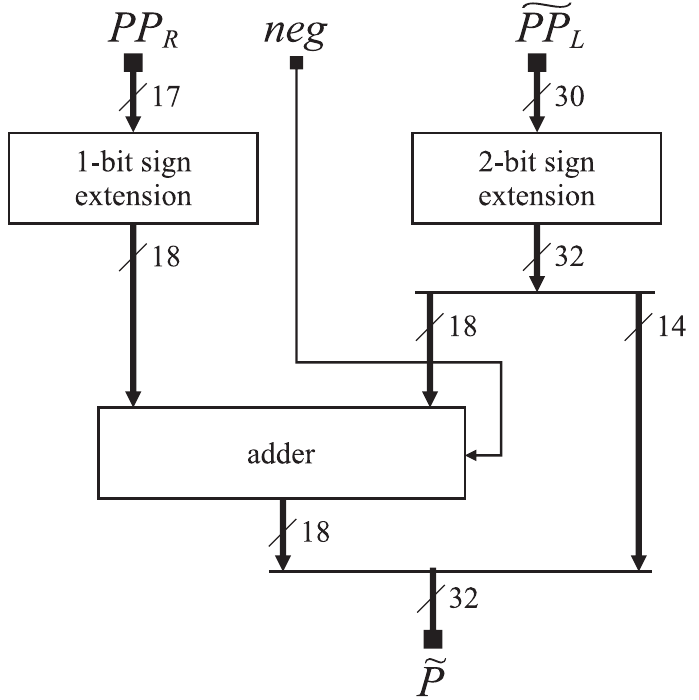
Figure 4. The partial products